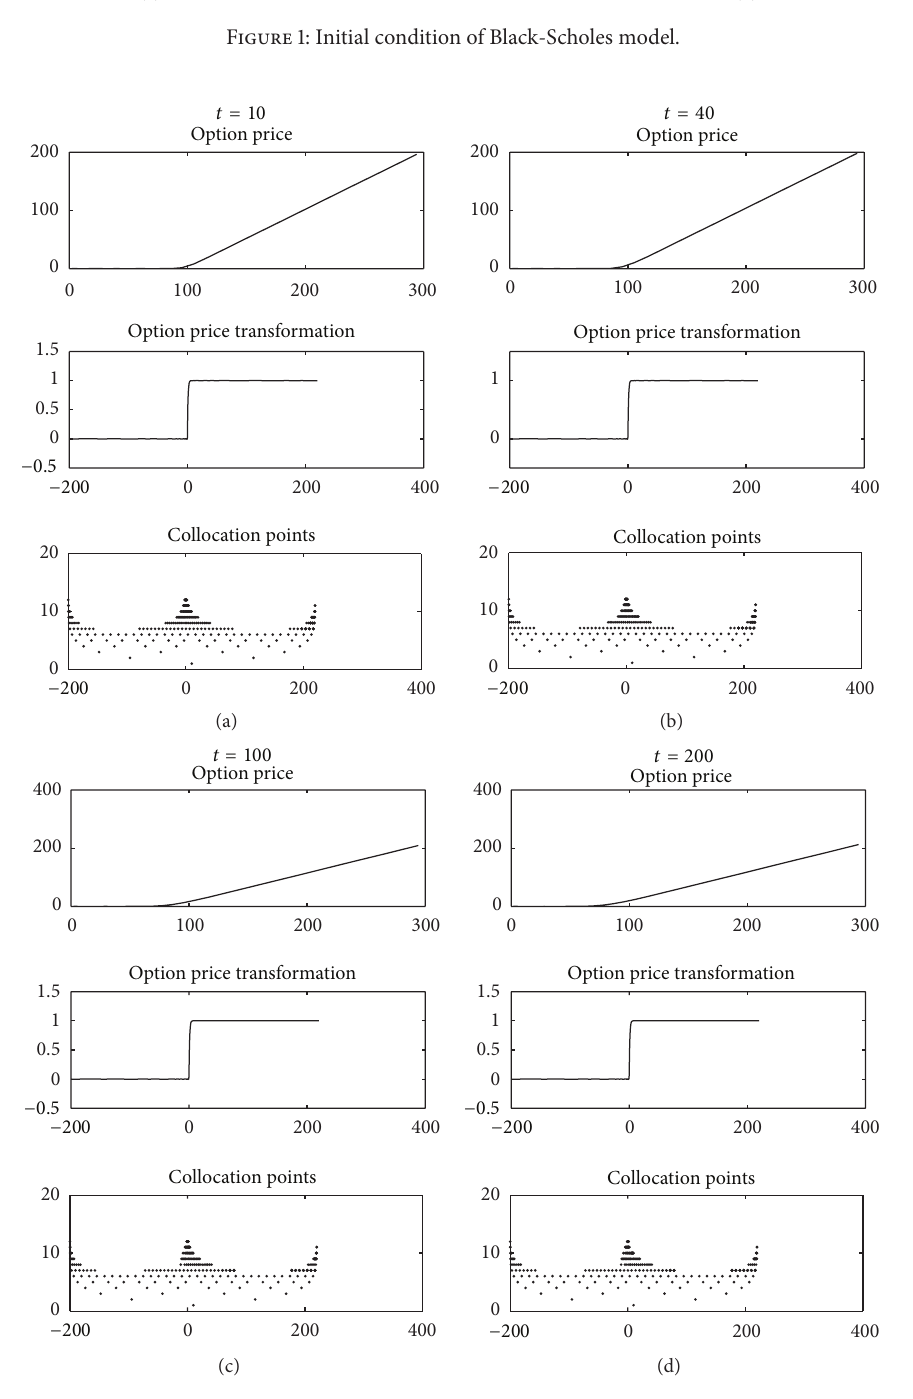
Figure 2: Evolution of the call option price with the parameter 𝑡